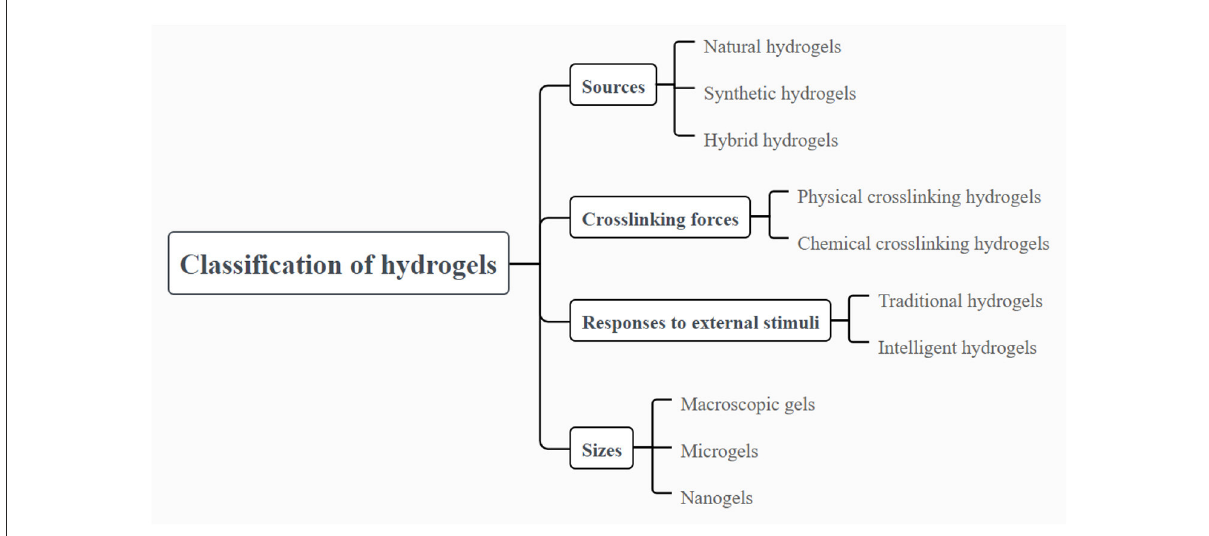
FIGURE1 Classification of hydrogels based on different parameters of the polymer sources, differ crosslinking forces, responses to external stimuli and the